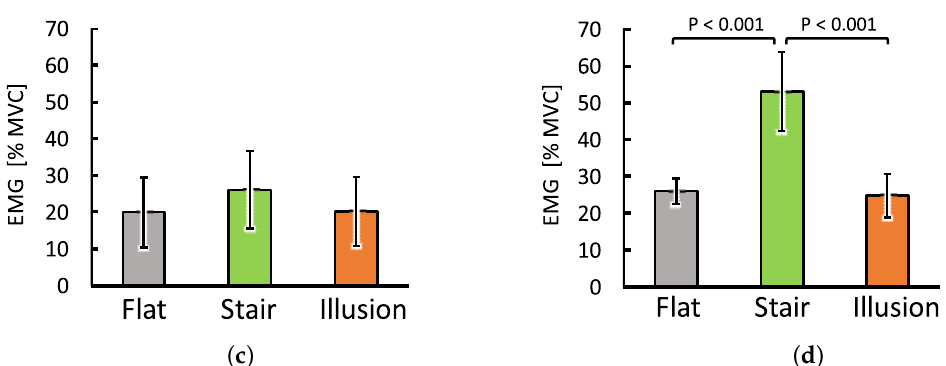
Figure 11. Peak maximal voluntary contraction (MVC) values (%) in four muscles during level walking (gray bars), stair-climbing (green bars), and virtual stair-climbing (orange bars): ( a ) vastus lateralis muscle, ( b ) biceps femoris muscle, ( c ) tibialis anterior muscle, and ( d ) gastrocnemius muscle.